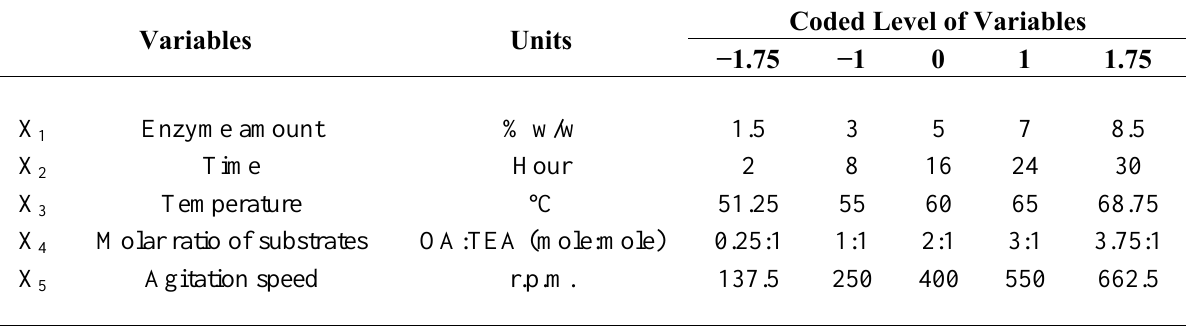
Table 3. Variables and their levels employed in the central composite